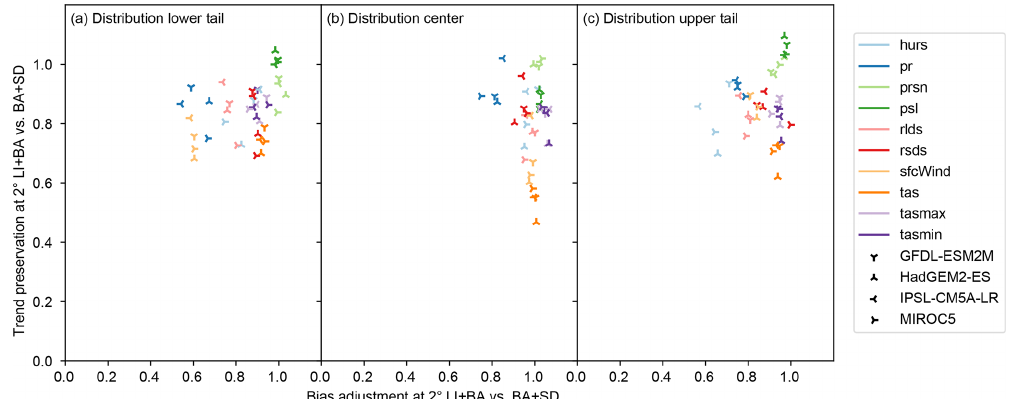
Figure 8. Same as Fig. 7 but for LI + BA and BA + SD applied for bias adjustment and statistical downscaling from 2 to 0 . 5 ◦ spatial resolution. Like in Fig. 7, absolute errors are calculated at 2 ◦ spatial resolution based on conservatively aggregated bias-adjusted and statistically downscaled climate simulation